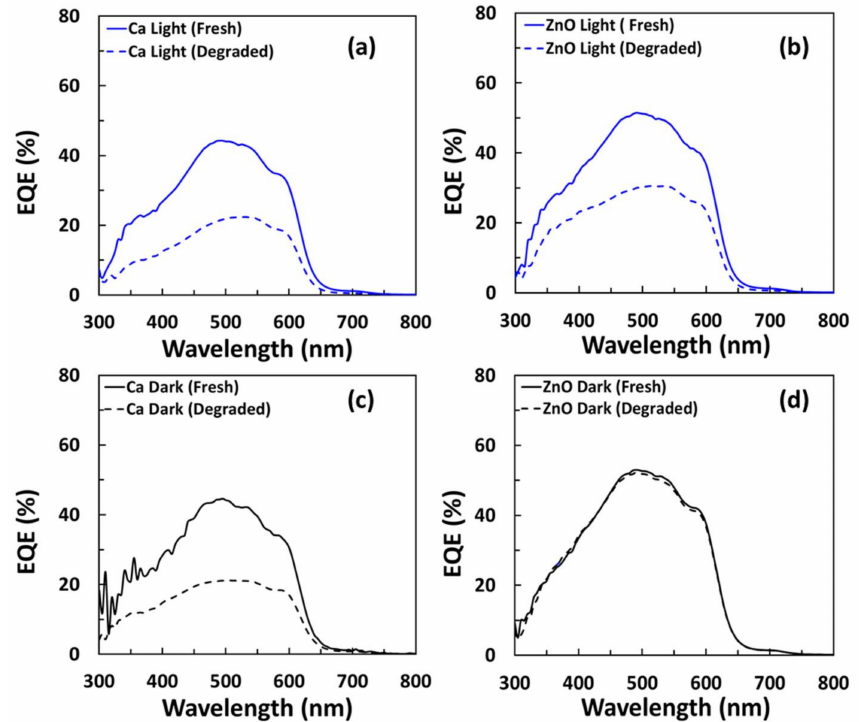
Figure 5. The External Quantum Efficiency (EQE) for Ca ( a , c ) and ZnO ( b , d ) OPV devices, solid lines denote fresh devices and dashed lines represent degraded OPV devices (blue color means light and black color means dark conditions). The EQE characteristics are measured within 2 ◦ C of the reference temperature (25 ◦ C). The scan recorded data at a 2 nm interval over the wavelength range 300–800